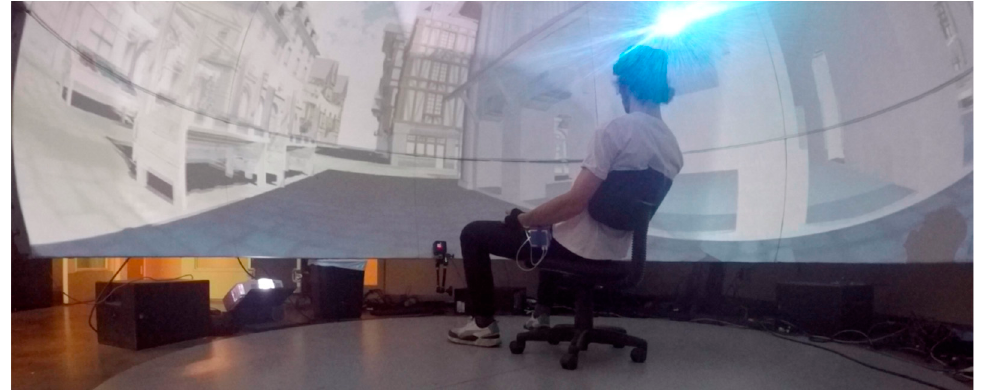
Figure 4. The immersive projection in the individual setting (Ind_Exp).